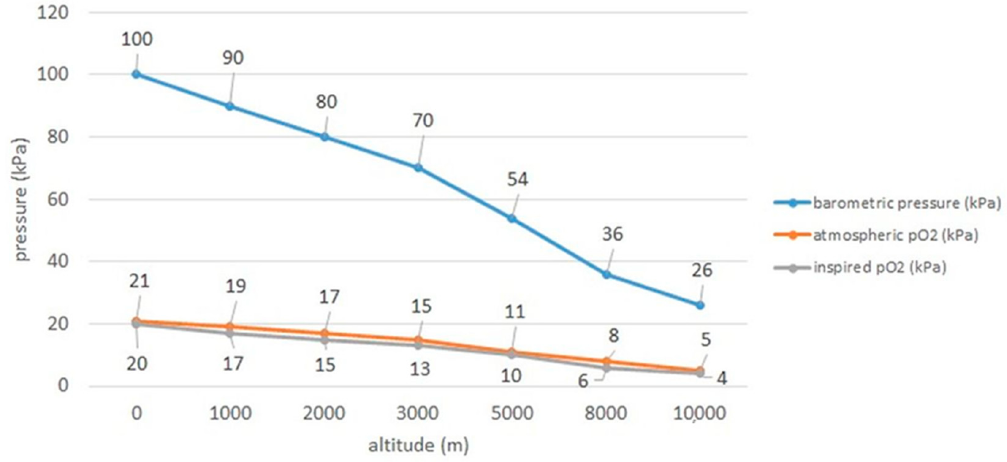
Figure 1. Relations of pressure and oxygen with rising altitude based on Samuels 2004 [7].